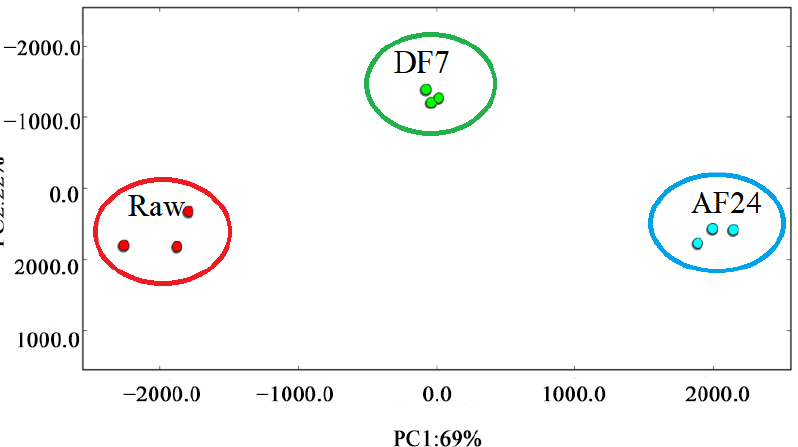
Figure 5. PCA based on the signal intensity obtained with hairtail fillets in different frying methods. Raw, untreated; DF7, deep fried for 7 min; AF24, air fried for 24 min.